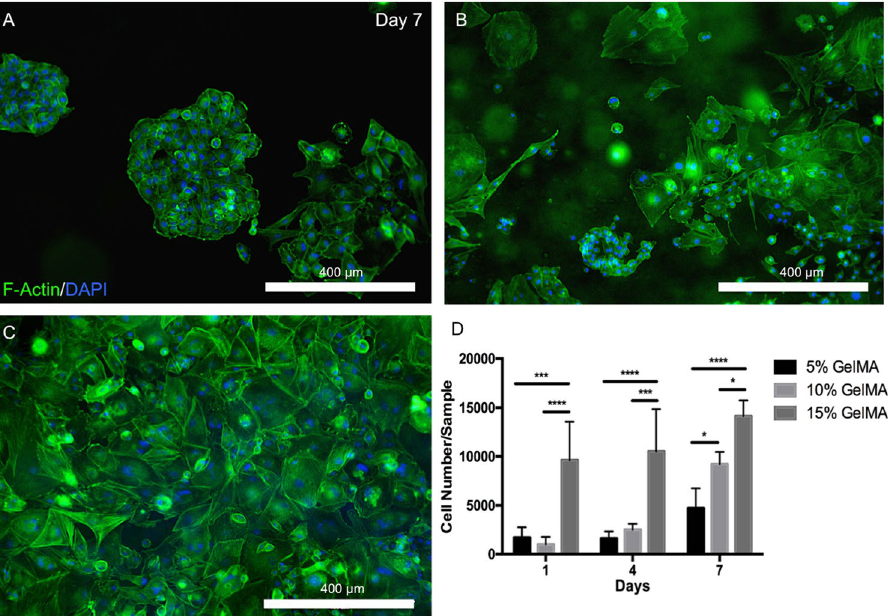
Figure 4. Spreading and proliferation of OD21 cells in 3D GelMA hydrogels. Representative images of OD21 cells encapsulated in ( A ) 5%, ( B ) 10% and ( C ) 15% GelMA hydrogels stained for actin (green) and DAPI (blue) shows increased cell spreading in stiffer over softer hydrogels. ( D ) Quantification of the number of cells per gel after 1, 4 and 7 days in culture indicates a significantly higher rate of proliferation of OD21 cells in scaffolds of higher polymer concentration. Statistical significance is represented by * for p < 0.05, *** for p < 0.001 and **** for p < 0.0001.